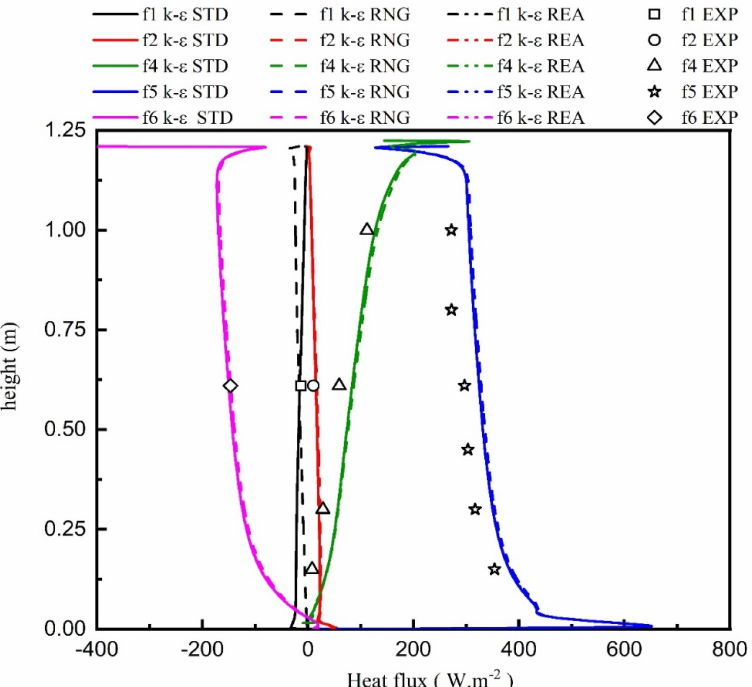
Figure 12. Experimental and numerical heat fluxes for the three glazings, according to k- ε models with an enhanced wall